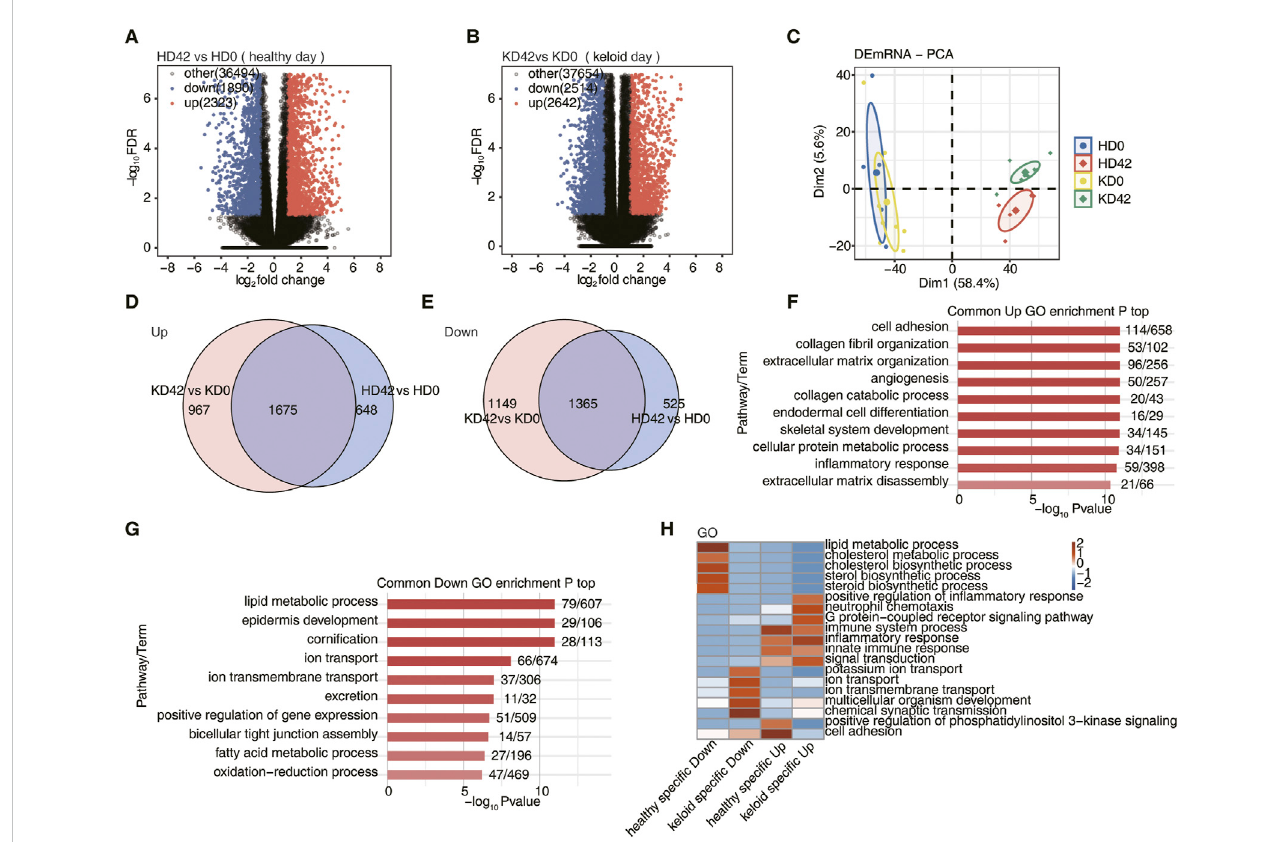
FIGURE 1 Differential gene analysis of local skin repair in patients with KPI and HC after 42 days of a wound. (A) Volcano plots to present all DEGs between HD42 (healthy day) and HD0 samples with DESeq. FDR ≤ 0.05 and FC (fold change) ≥ 2 or ≤ 0.5. (B) Volcano plots to present all DEGs between KD42 (keloid day) and KD0 samples with DESeq. FDR ≤ 0.05 and FC (fold change) ≥ 2 or ≤ 0.5. (C) Principal component analysis (PCA) based on FPKM value of all DEG. The ellipse for each group is the con fi dence ellipse. (D) Venn diagram showing the up-regulation overlap between KPI and HC. (E) Venn diagram showing the downregulation overlap between KPI and HC. (F) Bar plot showing the most enriched GO biological process results of the Common up-regulation. (G) Bar plot showing the most enriched GO biological process results of the Common down-regulation. (H) The top 5 most enriched GO terms (biological process) were illustrated for speci fi c genes among the different groups. The color scale shows the row-scaled signi fi cance (-log10 corrected p -value) of the